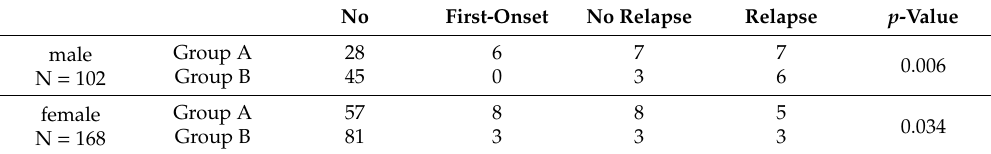
Table 2. Association between the rate of ATX change and post-SVR HCC